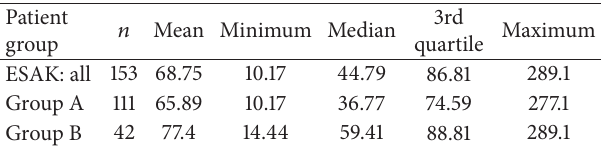
Table 3: Minimum, median, mean, third quartile, and maximum values of ESAK, exit air kerma, and thyroid entrance air kerma for all patients and for groups A and B separately.